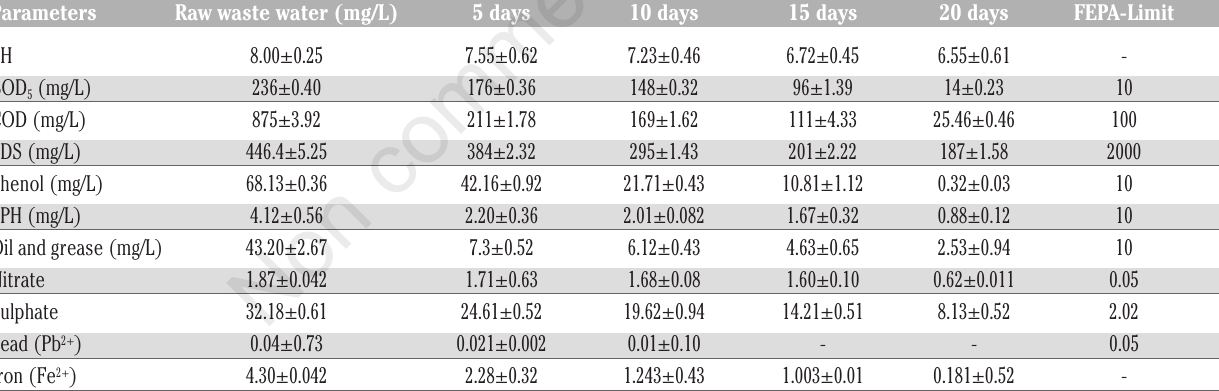
Table 1. Physicochemical characterization of raw and treated wastewater of Kaduna Refining & Petrochemical Company (KRPC), Kaduna, Nigeria, compared with Federal Environmental Protection Agency (FEPA, Abuja, Nigeria)-Limit. Parameters